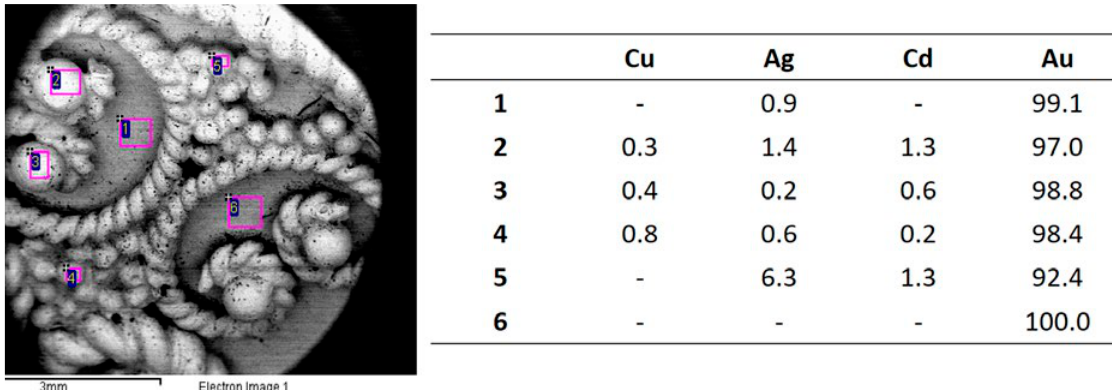
Figure 5. Earring N.Inv. 53582 SEM image in backscattered electrons with indicated the areas investigated by EDS method. The table shows the values of the chemical elements in percentage by weight